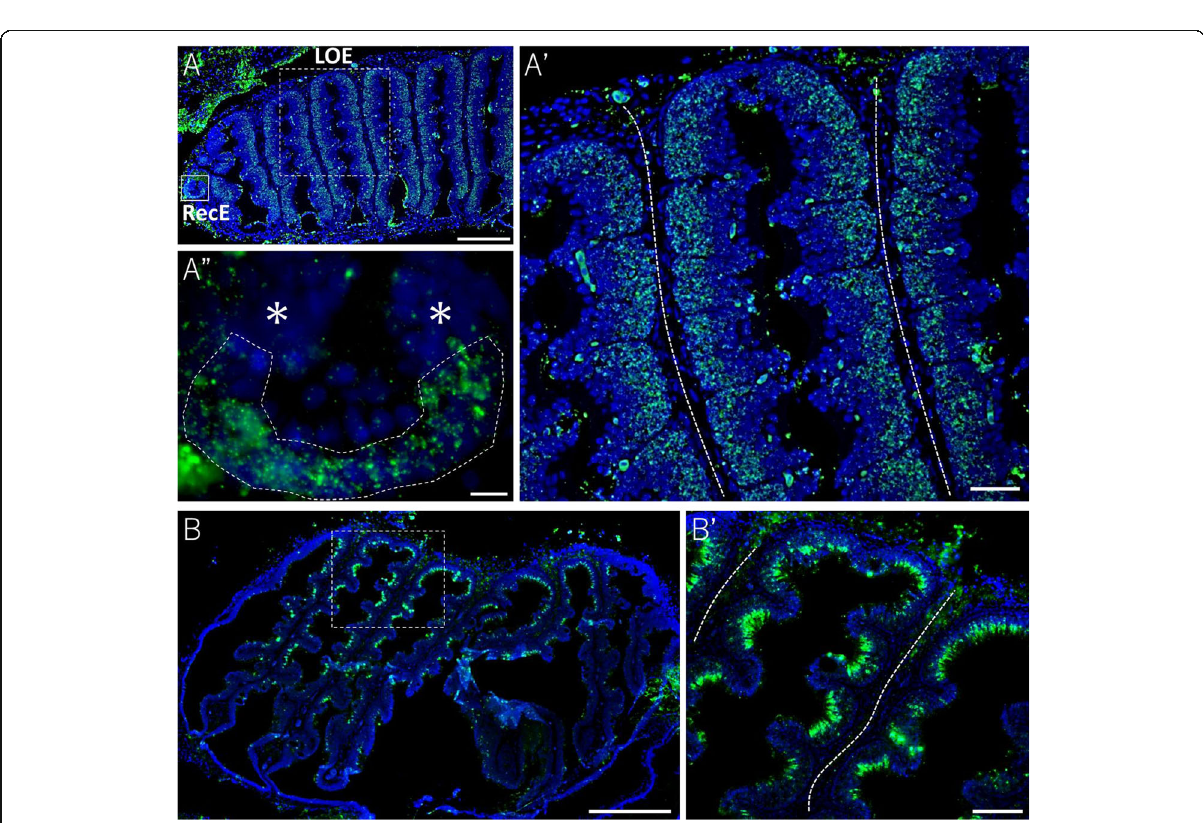
Fig. 6 Expression pattern of ancV1R in lungfish and gar. ( A ) The expression pattern of ancV1R (green) in a sagittal section of the olfactory organ of lungfish. The dotted and solid squares indicate LOE and RecE, respectively. (A ’ ) High magnification view of the dotted square in (A). Note that ancV1R is expressed in the basal layer of the LOE. (A ” ) Higher magnification view of the solid square in (A). ancV1R is expressed in the sensory epithelium of the RecE surrounded by a dotted line. Asterisks indicate the location of the nonsensory epithelium. ( B ) The expression pattern of OMP in a horizontal section of the olfactory organ of spotted gar. (B ′ ) Higher magnification of the dotted square in (B). Note that ancV1R is expressed by most sensory neurons scattered in the concave regions of the lamella. The dotted line indicates the center of the lamellae. The scale bars indicate 500 μ m (A, B), 100 μ m (A ’ , B ′ ), or 20 μ m (A ”